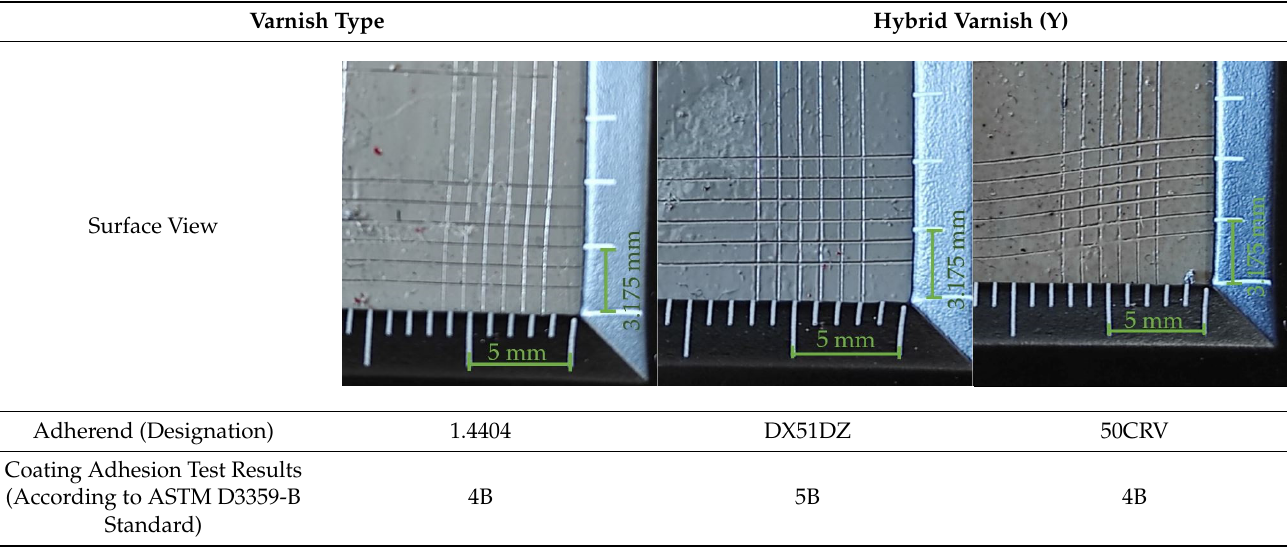
Table 10. Test results for the adhesion measurement of coatings to the substrate—hybrid varnish (Y).